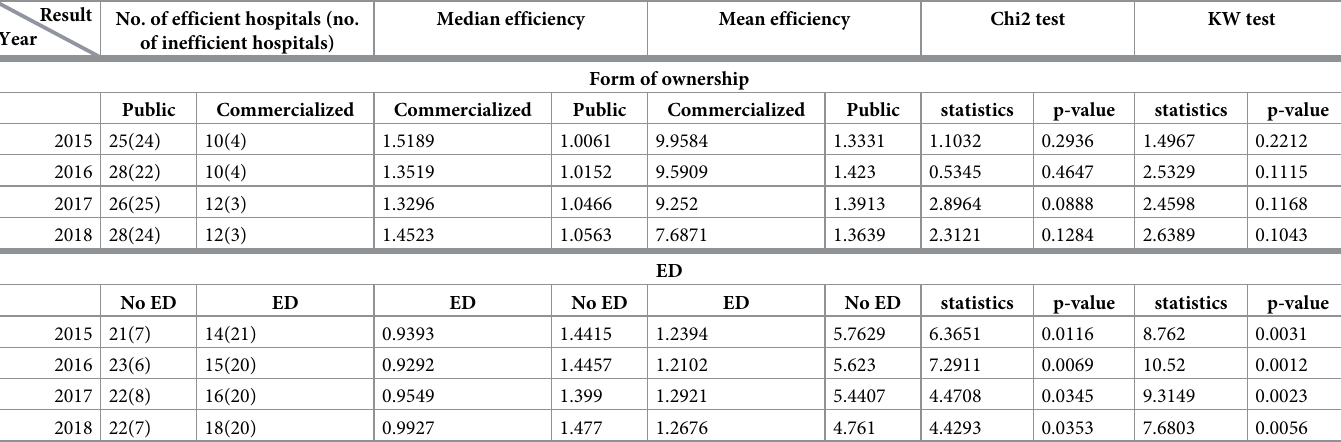
Table 5. The efficiency of hospitals with an ICU with respect to the form of ownership and ED ( detailed approach). Result Year